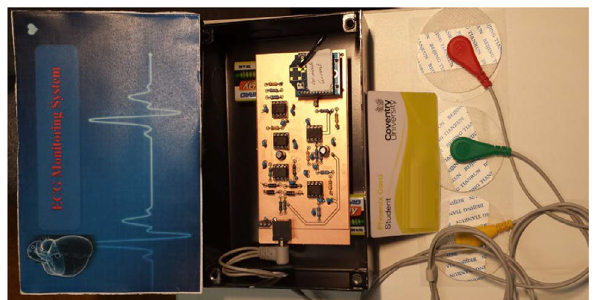
Fig. 10 Final design in box